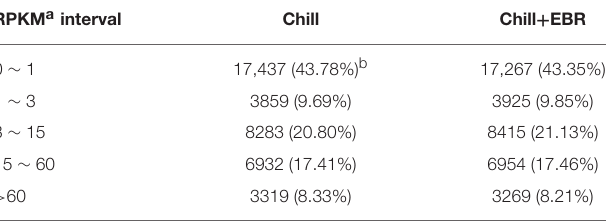
TABLE 3 | Statistics of genes in different expression-level interval.